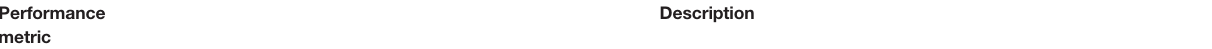
TABLE 3 | Descriptions of performance metrics used to evaluate the random forest (RF) prediction